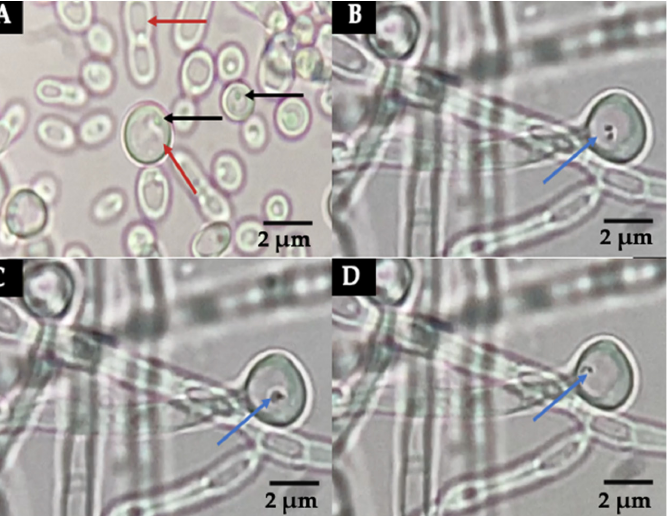
Figure 3. Wet mounts of yeast cells harboring bacteria-like bodies (Y-BLBs). Images, similar to observations of other co-cultures, correspond to a co-culture of H. pylori H707 strain and C. albicans VT-3 strain, incubated under an anaerobic condition: ( A ) Yeast cells from a pure culture of the C. albicans VT-3 cells lacking BLBs in their vacuole (red arrow), nuclei of the yeast cells indicated with black arrows; ( B – D ) show the changes in positions of BLBs in the vacuoles (blue arrows) in images taken at 1 s intervals. The actual movement of the BLBs is shown in Video S1.